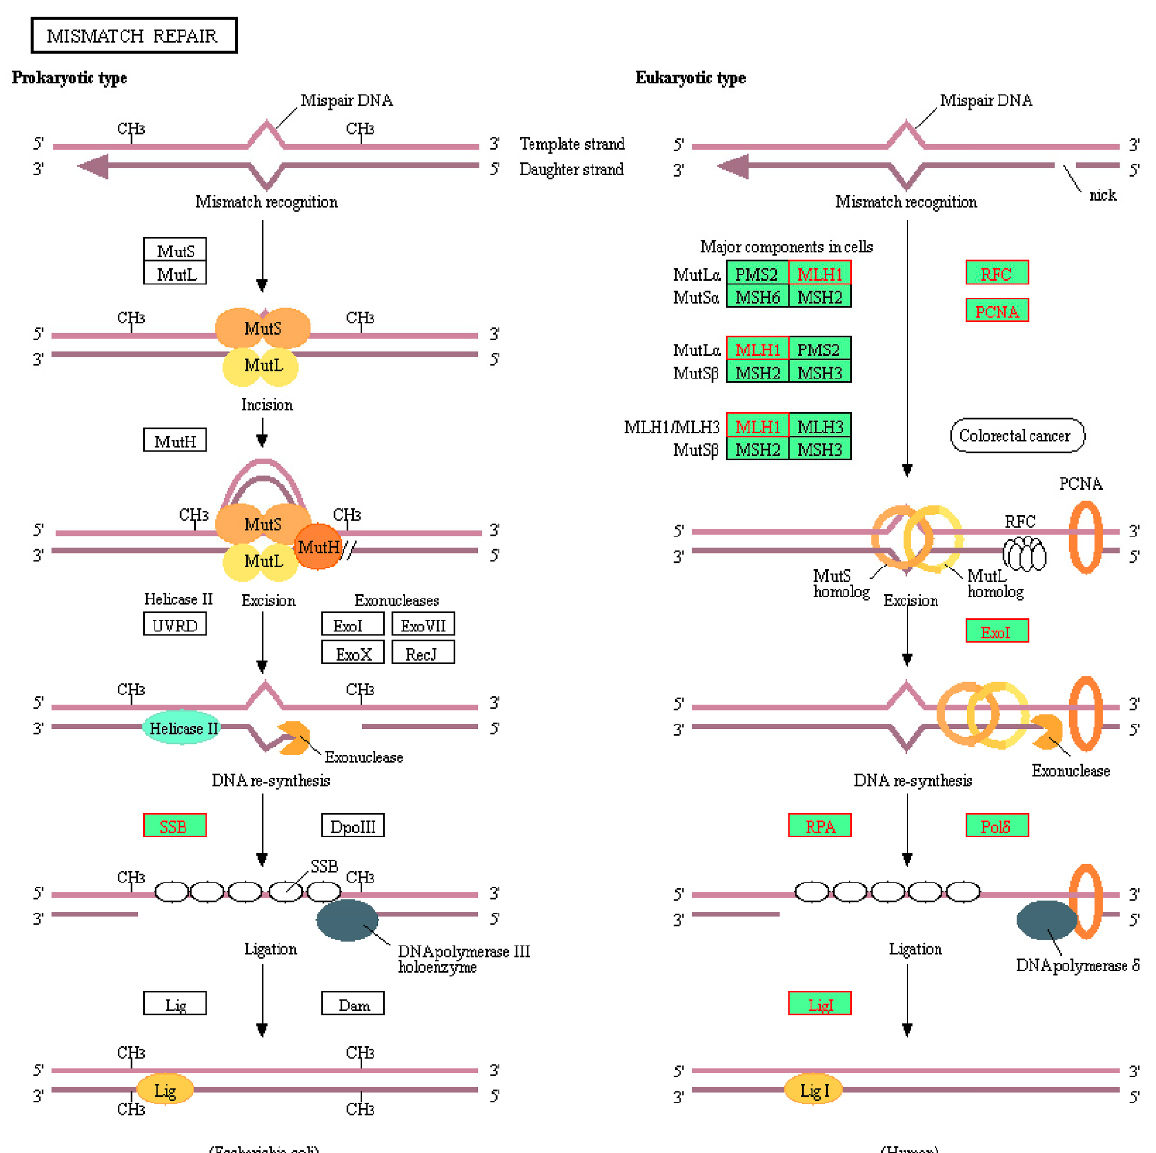
Figure 5. Visualization of the GSEA-enriched genes from the leading-edge subset of the mismatch repair pathway in CPT-CEF-treated colon cancer cells. The pathway was extracted from the KEGG database, and the GSEA-enriched genes obtained from the data set were highlighted red. The underexpression of these genes is predicted to have an impact in the downstream signaling involved during mismatch repair.